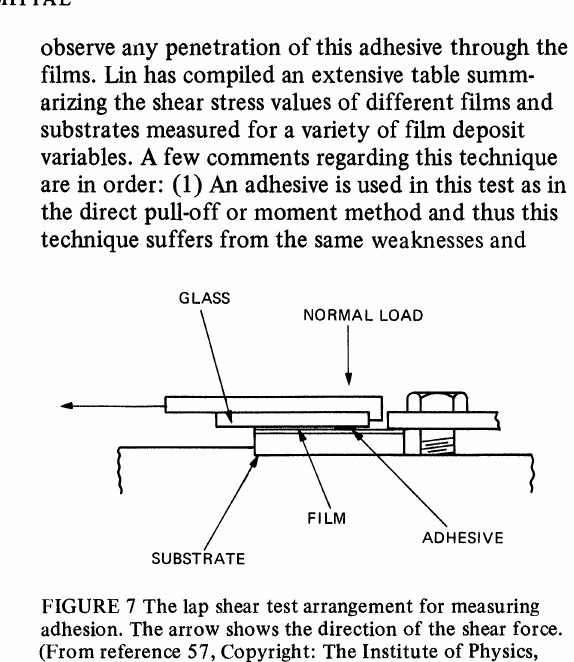
FIGURE 7 The lap shear test arrangement for measuring adhesion. The arrow shows the direction of the shear force. (From reference 57, Copyright: The Institute of Physics,